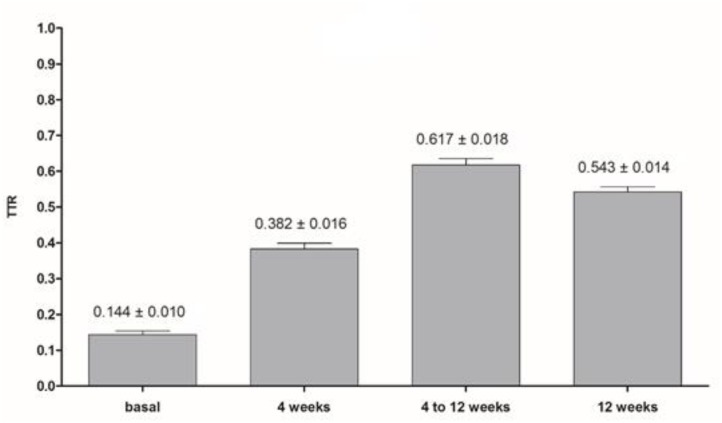
Comparison between the basal and the TTRs calculated in different times (TTR 4 weeks: based on INR tests from visits 0 to 4; TTR 4–12 weeks: based on INR tests from visits 4–12; TTR 12 weeks: based on INR tests from visits 0–12). Wilcoxon signed-rank test was performed for comparison two by two (basal and TTR 4 weeks; basal and TTR 4–12 weeks; and, basal and TTR 12 weeks); all p-values were p < 0.001. Data are expressed as mean ± SE. Basal TTR is the TTR calculated with the 3 last INR tests before entering at prospective phase of the study with a cut-off for selection TTR < 0.500, TTR 4 weeks (TTR calculated with the INR tests from visits 0 to 4 at prospective phase of the study), TTR 4–12 weeks (TTR calculated with the INR tests from visits 4 to 12 at prospective phase of the study) and TTR 12 (TTR calculated with the INR tests from visits 0 to 12 at prospective phase of the study).